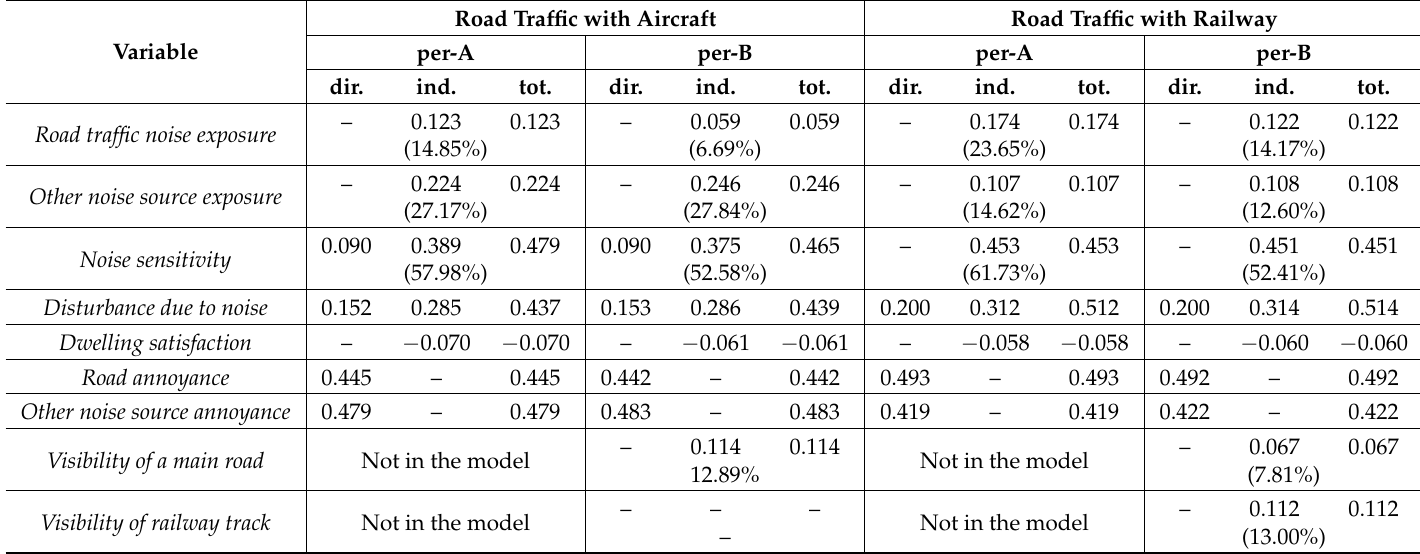
Table 11. Direct (dir.), indirect (ind.) and total (tot.) effects of all variables affecting Noise annoyance due to combined noises in perceptual Models per-A and per-B. Contributions of exogenous variables are given in percentage between